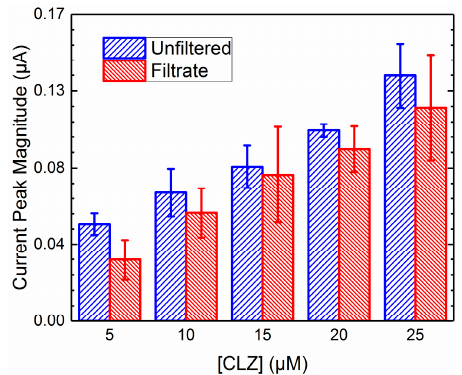
Figure 4. Current peak magnitudes of unfiltered solutions and filtrates of AAG and CLZ mixtures across varying concentrations of CLZ. Values displayed as mean ± standard deviation; p = 0.90 between unfiltered vs. filtrate groups, n = 3.